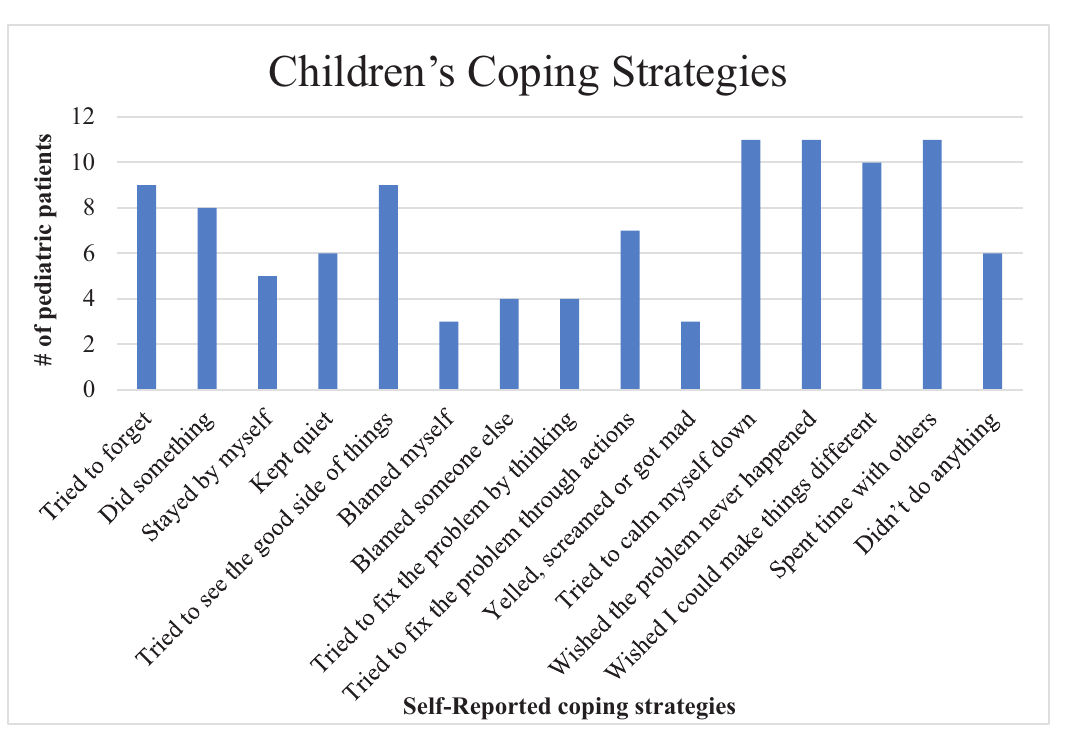
Figure 5. Self-reported coping skills of children with